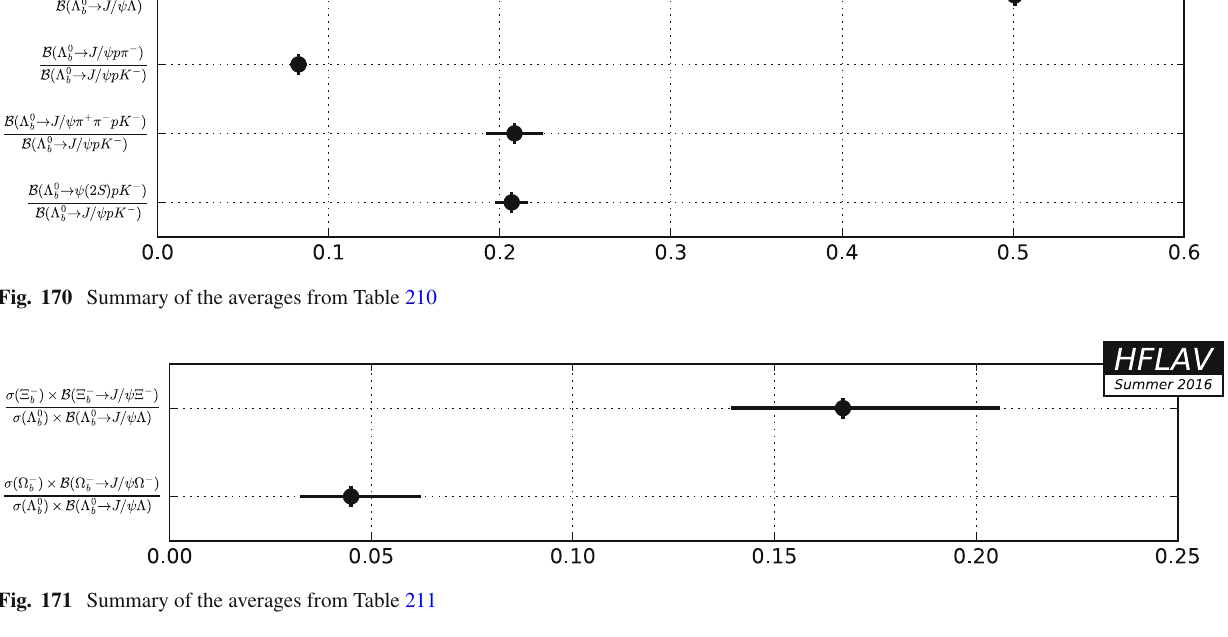
Averages of b baryons decays to charm baryons are shown in Tables 213, 214, 215, 216, 217 and Figs. 172, 173, 174, 175.